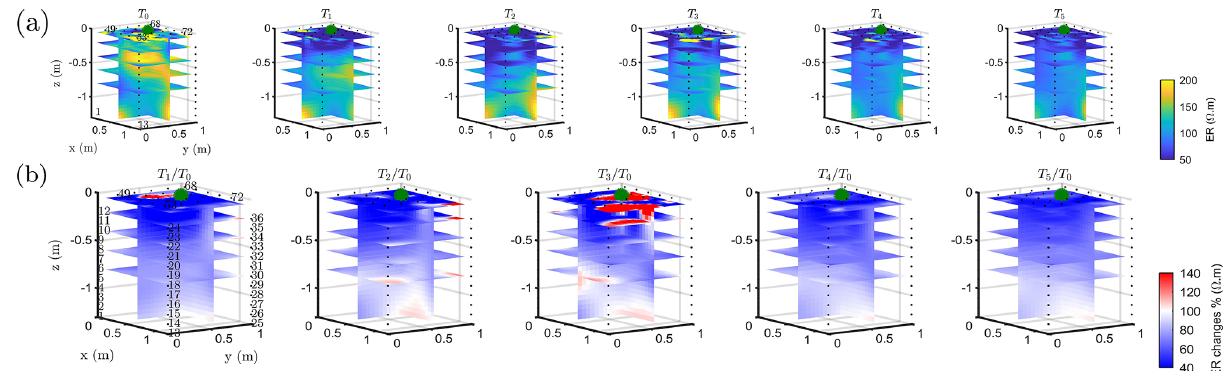
Figure 4. Three-dimensional ERT results for plant B (plant A, in Appendix Fig. B1). The volume is sliced at the tree stem position (vertically) and at five depths (0.05, 0.2, 0,4, 0.6 and 0.8m). (a) Three-dimensional inversion of the resistivity (in (cid:127) m, log scale) from the background time T 0 , during irrigation T 1 and after irrigation. (b) Time-lapse inversion (following Cassiani et al., 2006) showing the ratios (in % of ER changes) between time step T i and background time T 0 (100% in white means no change).